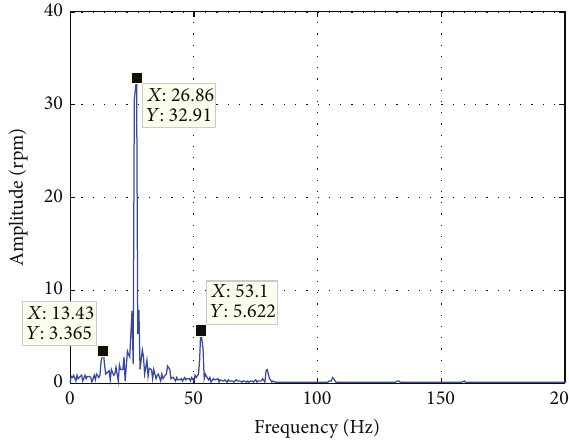
Figure 27: Frequency spectrum of engine speed.